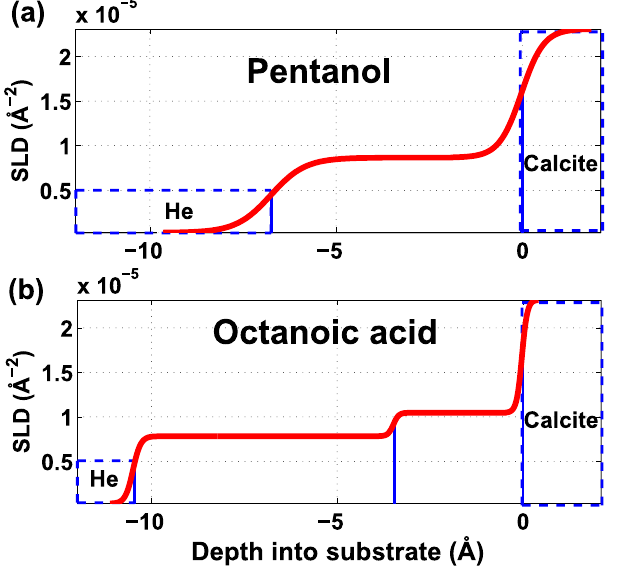
Figure 6. Scattering length density (SLD) based on the fitted model. Calculated SLD profile for ( a ) pentanol, with a total thickness of 6.7 Å and ( b ) octanoic acid, with a total thickness of 10.5